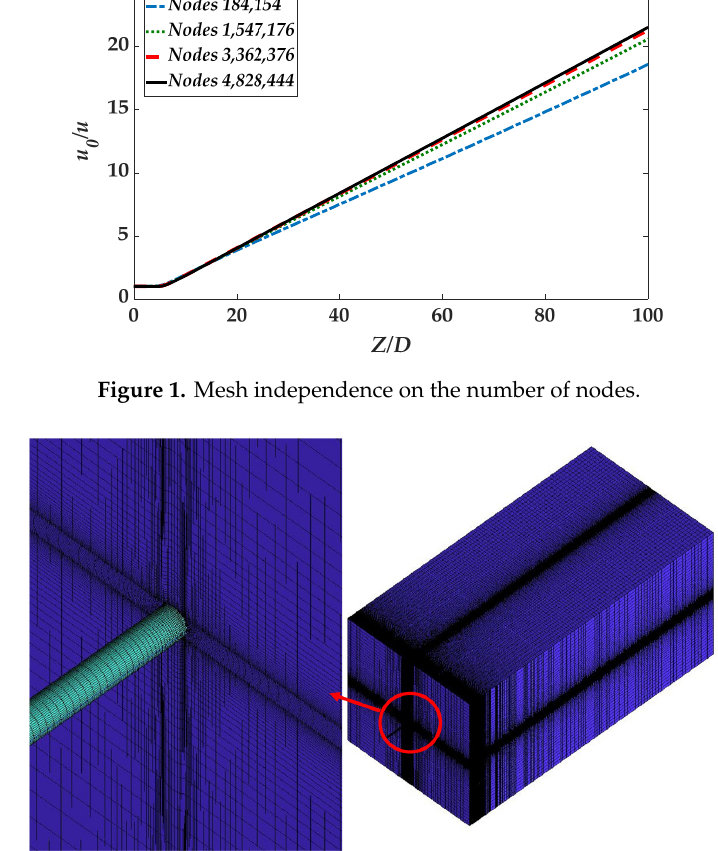
Figure 2. Hexahedral mesh for CFD simulations.